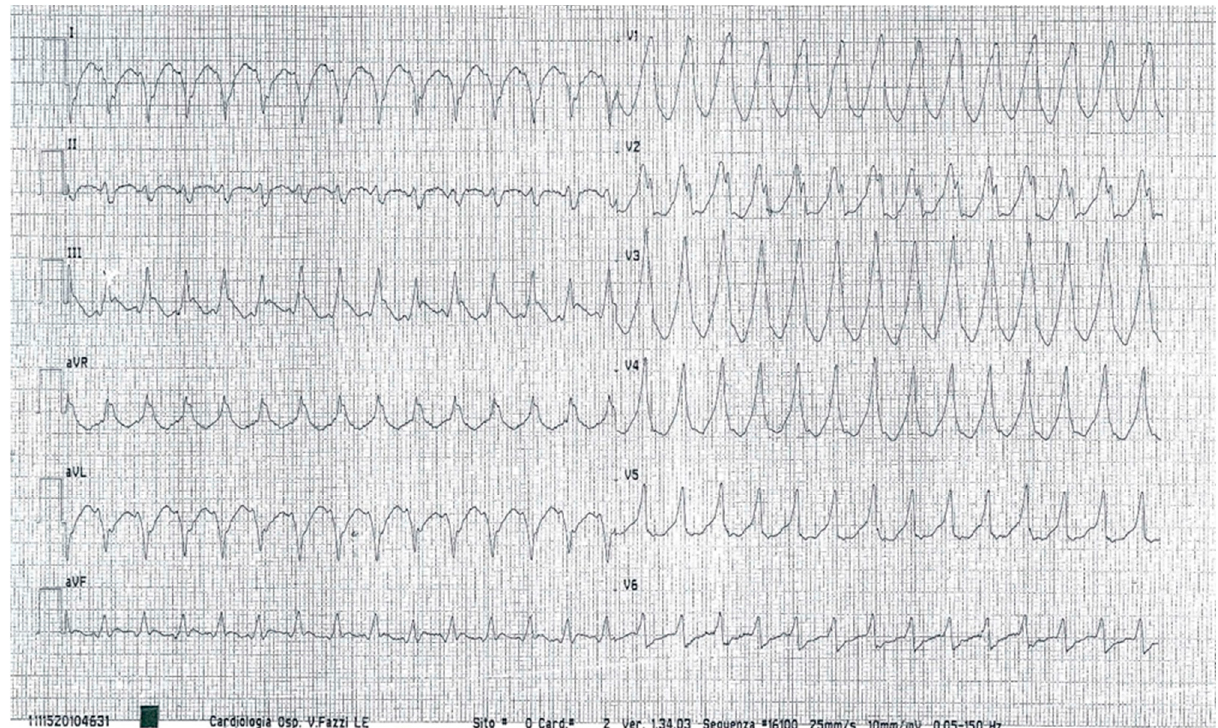
Figure 1. The twelve-lead ECG recorded a monomorphic and sustained ventricular tachycardia, originating from the left ventricle.